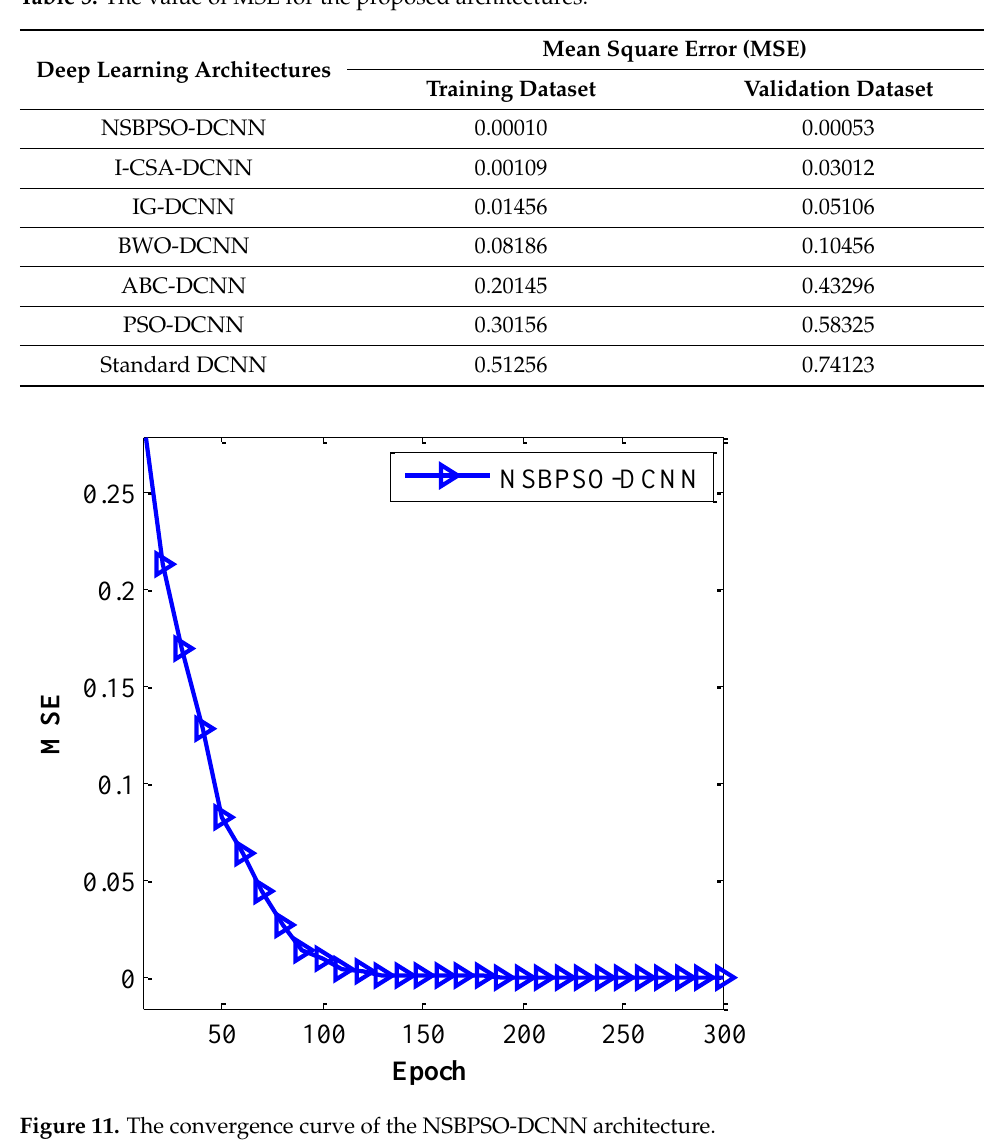
Figure 11. The convergence curve of the NSBPSO-DCNN architecture. A nonparametric statistical test called Wilcoxon has been used to show the significant differences between all models. The Wilcoxon test is applied to measure the similarity of two dependent degree-scale samples. Derrac et al. [69] provided the full details of this nonparametric statistical test. All architectures have been implemented with 25 runs for intrusion detection in IoT systems. The mean values of the fitness function were normalized and then the Wilcoxon test results were obtained using SPSS software. Table 6 shows the R + , R − , and p -value for all NSBPSO-DCNN pairwise comparisons. As shown in Table 6, NSBPSO-DCNN shows an improvement versus I-CSA-DCNN, IG-DCNN, and BWO-DCNN with a level of significance α = 0.05, and versus ABC-DCNN, PSO-DCNN, and Standard DCNN with a level of significance α = 0.01. According to the results, NSBPSO- DCNN has a strong performance compared to the other